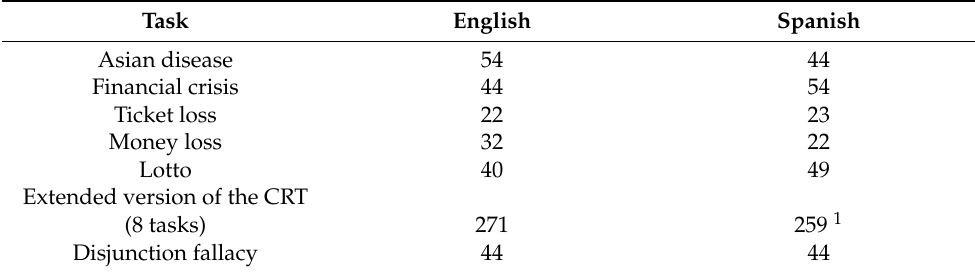
Table 5. Summary of participants per task.